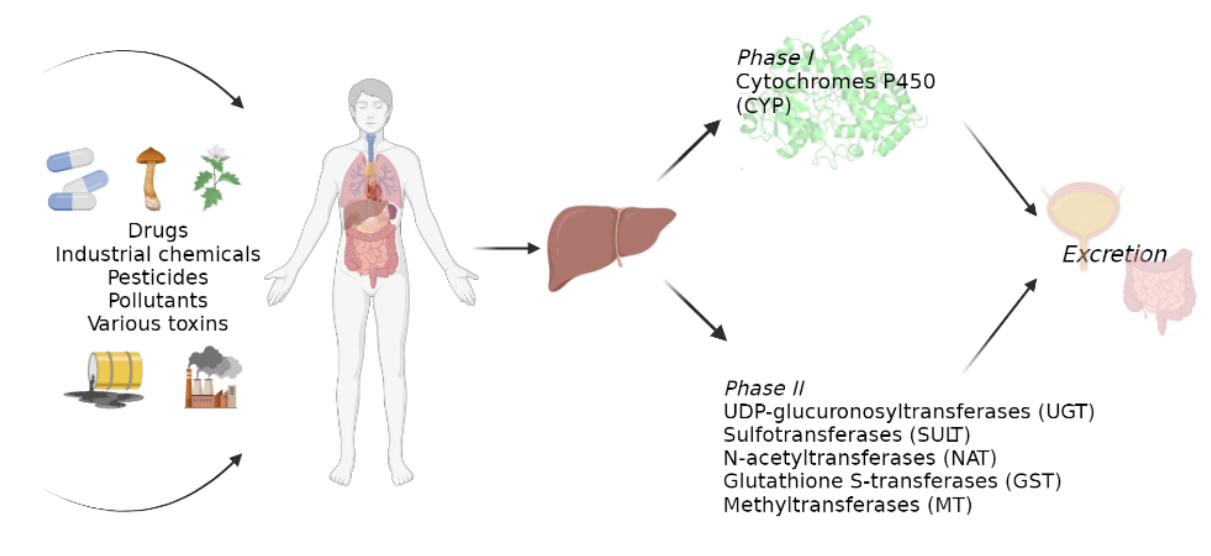
Fig. 1. Biotransformation of xenobiotics in liver. Drugs, industrial chemicals, pesticides, pollutants, secondary plant metabolites and various toxins are metabolized by enzymes (abbreviations in parenthesis) of Phase I and Phase II of xenobiotic metabolism. These metabolic pathways modify the structure of foreign compounds, leading to their eventual excretion from an organism. (Created with